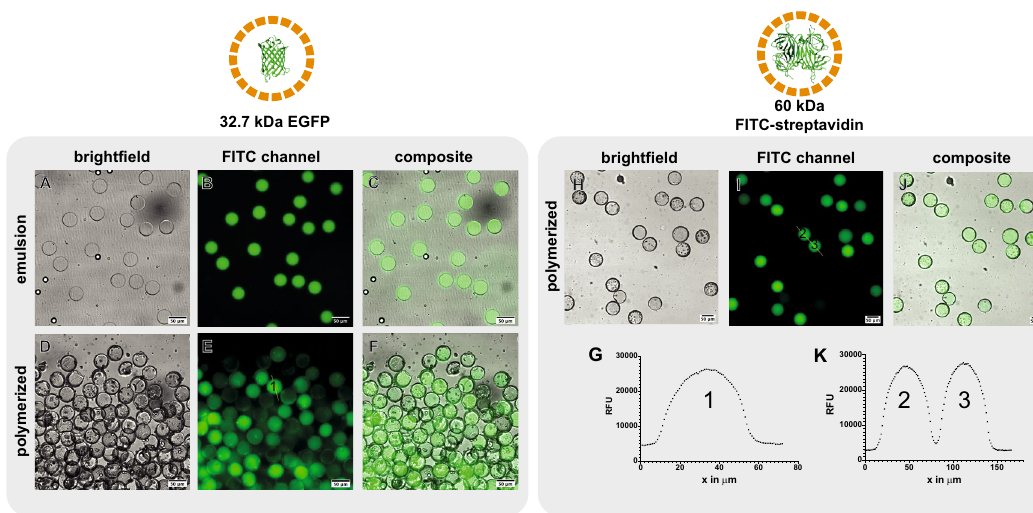
Figure 3. Direct encapsulation of proteins inside semi-permeable PEG-DA 258 capsules. EGFP was added to the aqueous inner phase for direct encapsulation. (A–C) Microscope images of double-emulsions showing a fluorescent signal in the FITC channel. (D–F) After polymerization, the fluorescent signal was still present in the interior of most capsules. Variability in the pore size or a size cutoff close to the 32.7 kDa EGFP resulted in some protein leakage. (G) Fluorescent intensity profile of the capsule indicated in panel E. The fluorescent profile suggests a homogeneous distribution of EGFP in the interior of the capsule without protein adsorption to the shell material. (H–J) Microscope images of polymerized capsules containing FITC-streptavidin after direct encapsulation. Fluorescent signal is present in all capsules, suggesting that the pore size is too small for FITC-streptavidin leakage. (K) Fluorescent profile across two capsules from panel I. The profile suggests a homogeneous distribution of FITC-streptavidin in the interior of the capsule without protein adsorption to the shell